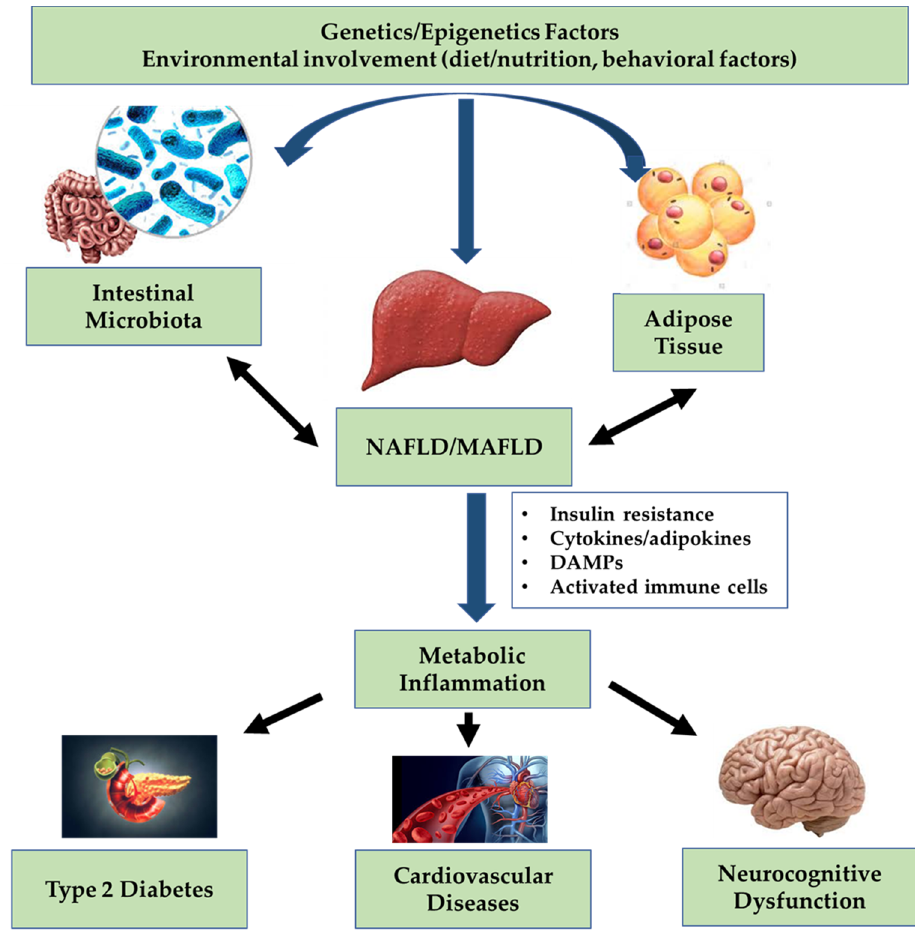
Figure 1. Interplay between liver and body targets in non-alcoholic fatty liver disease (NAFLD)/metabolic associated fatty liver disease (MAFLD).